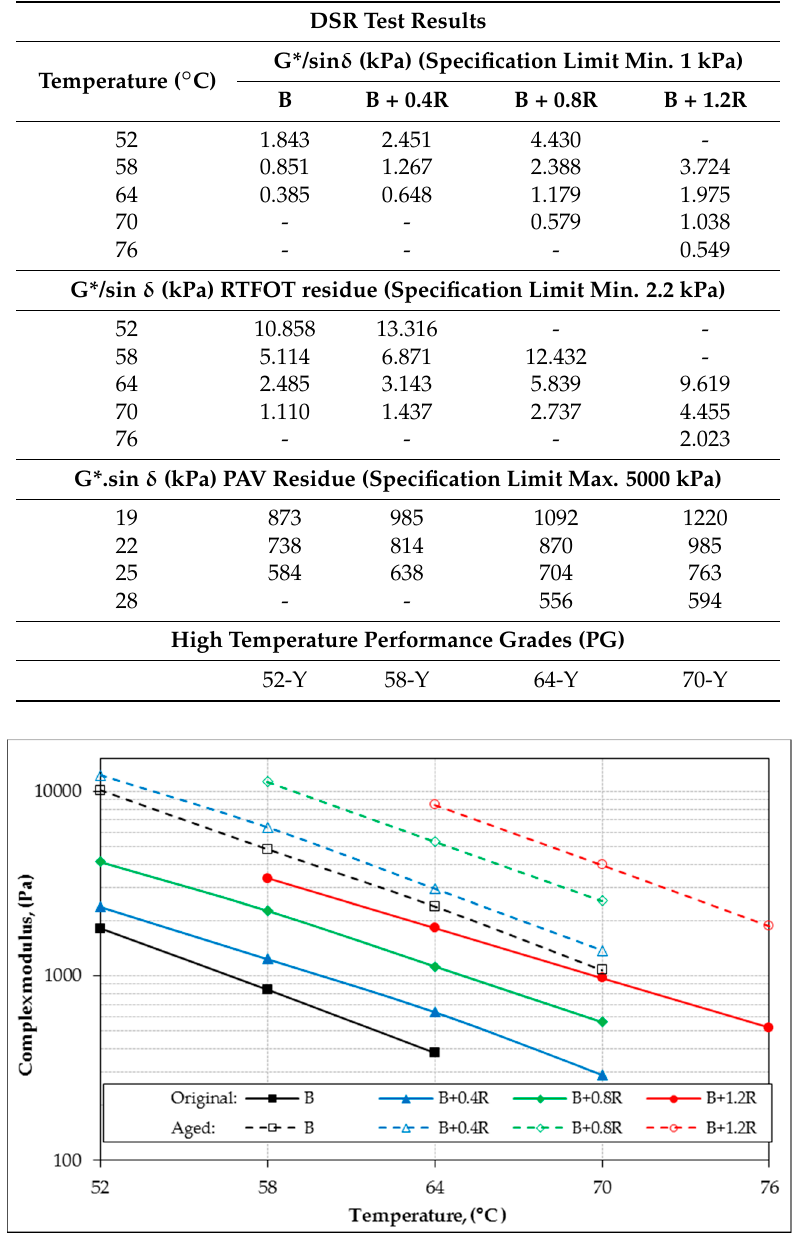
Figure 11. The complex modulus (G*) and temperature relationship of binders.